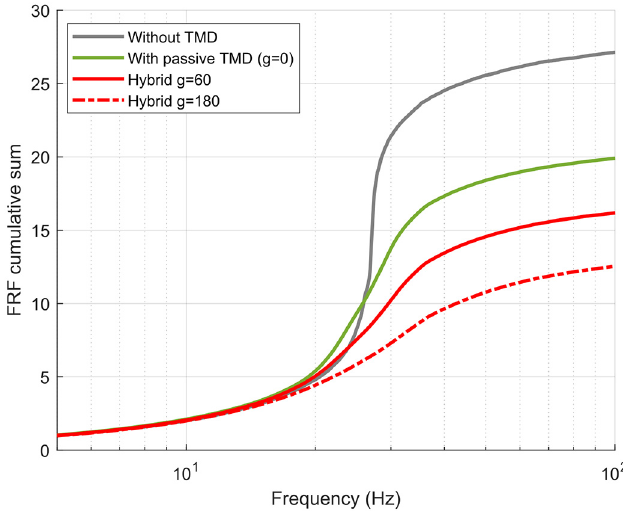
Fig. 11. Cumulative sums of FRF represented in Figure 10.